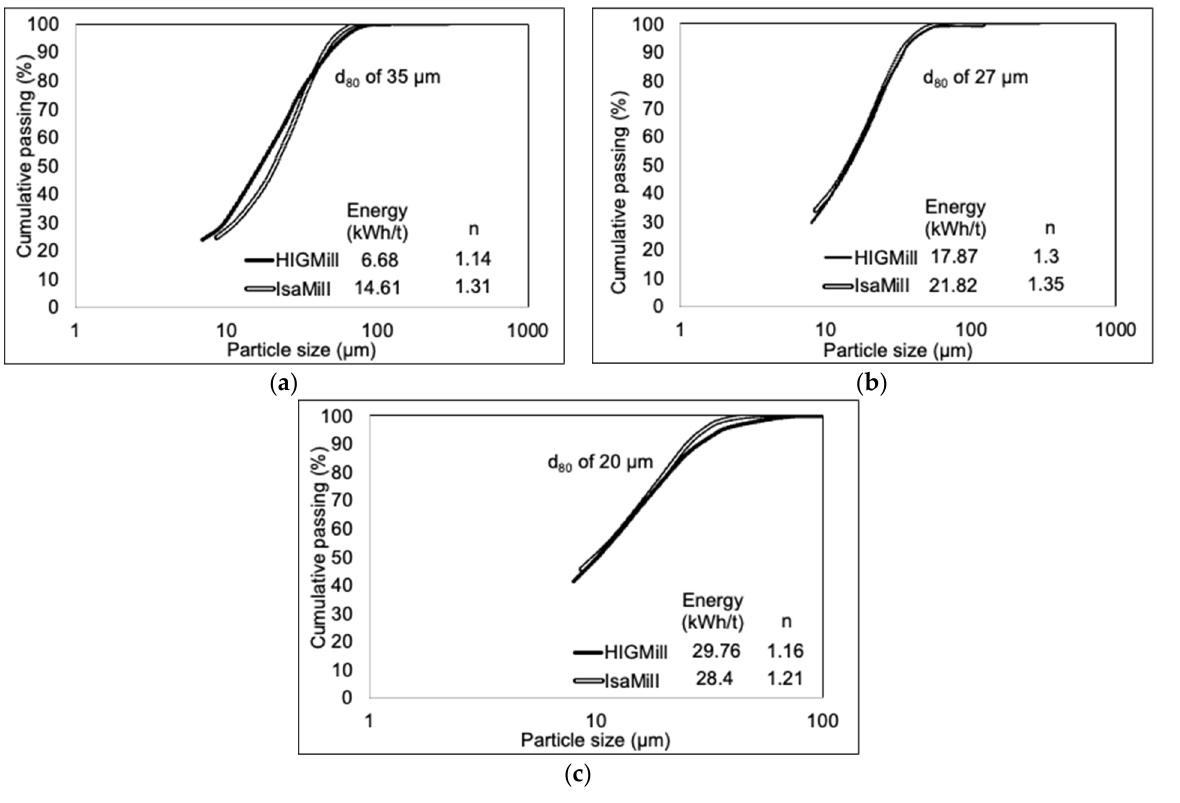
Figure 12. The variations in the shape of the product size distributions of ( a ) 35 µ m, ( b ) 27 µ m and ( c ) 20 µ